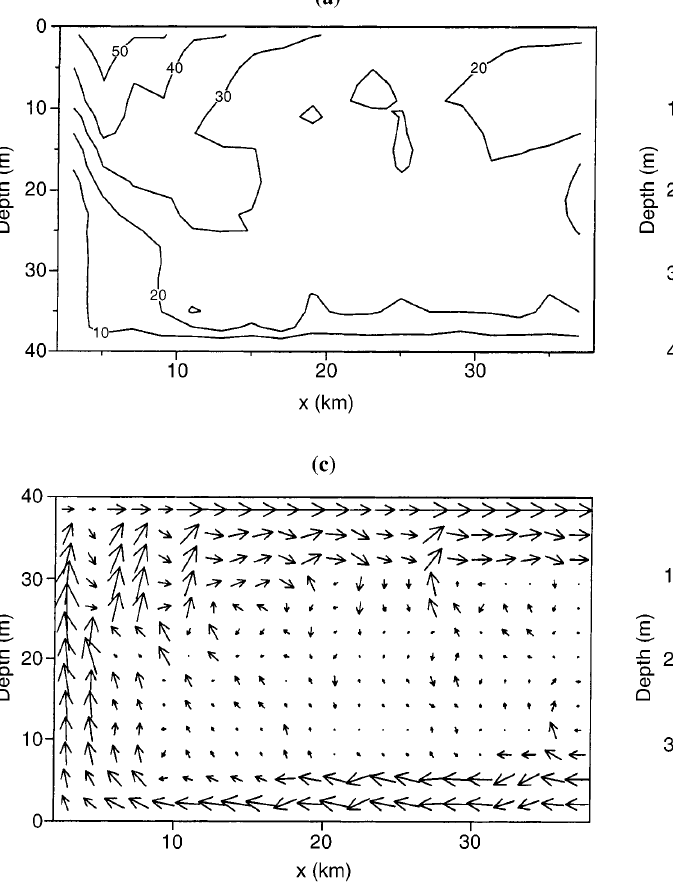
Fig. 12a–d. Optimal solution and optimal turbulent viscosity ob- tained by the assimilation of the noisy temperature data of the coastal upwelling. x (km) is the distance to the coast. a Velocity v (cid:133) cm (cid:1) s (cid:255) 1 (cid:134) , b